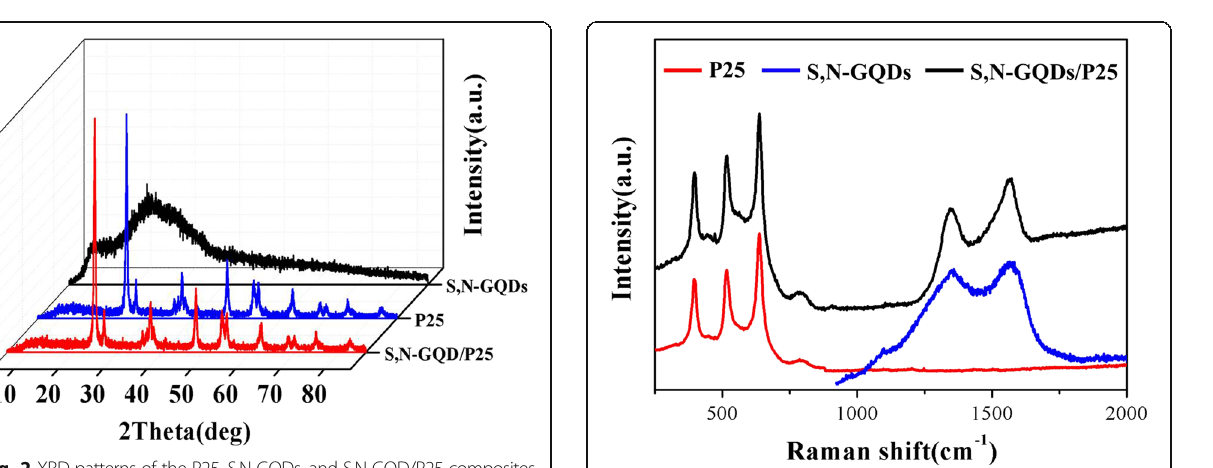
Fig. 2 XRD patterns of the P25, S,N-GQDs, and S,N-GQD/P25 composites